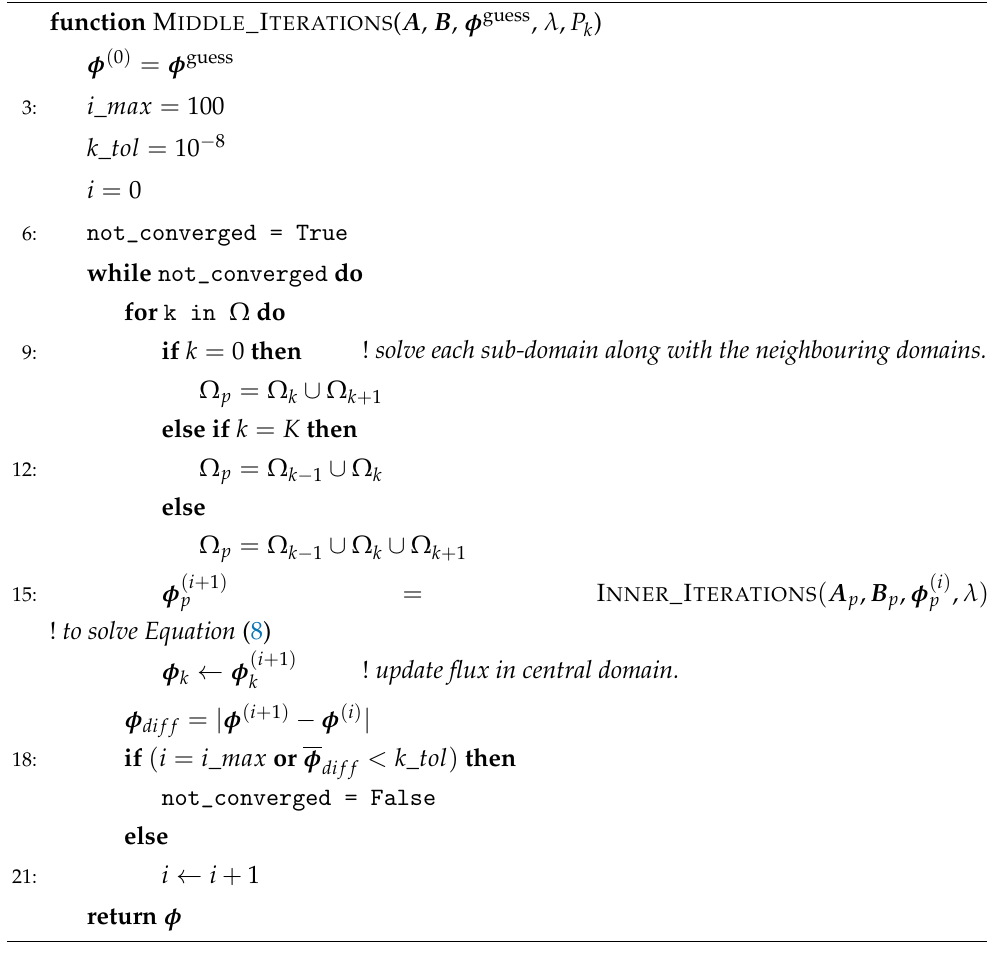
Algorithm 4 Domain decomposition method: middle iterations.